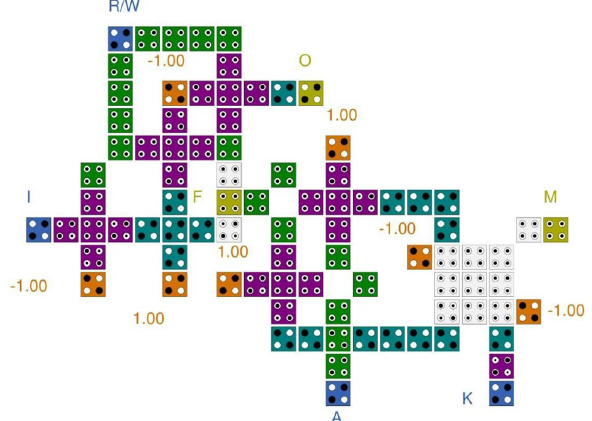
Fig. 10 The designed 1-bit CAM circuit in [5]